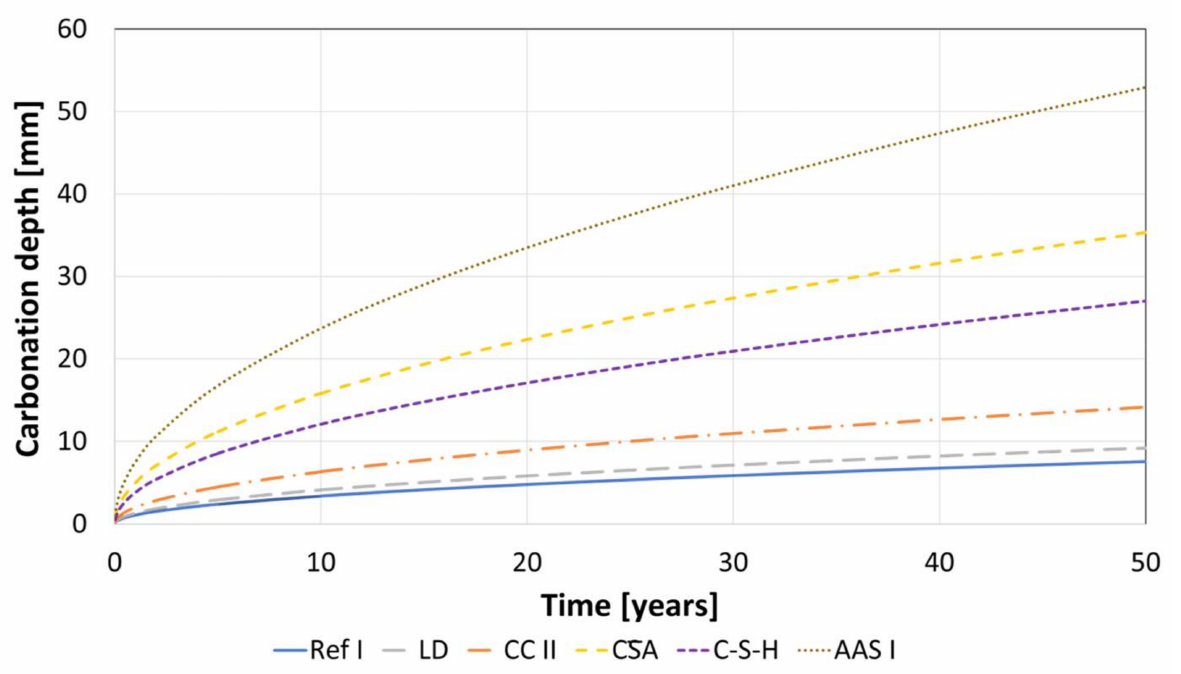
Figure 10. Extrapolation of the natural carbonation depths, calculated from accelerated